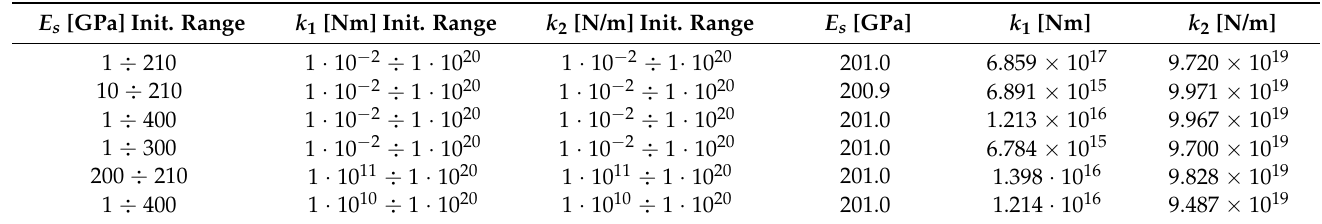
Table 7. Different variation ranges and optimal values of the unknown parameters for the cantilever beam case.